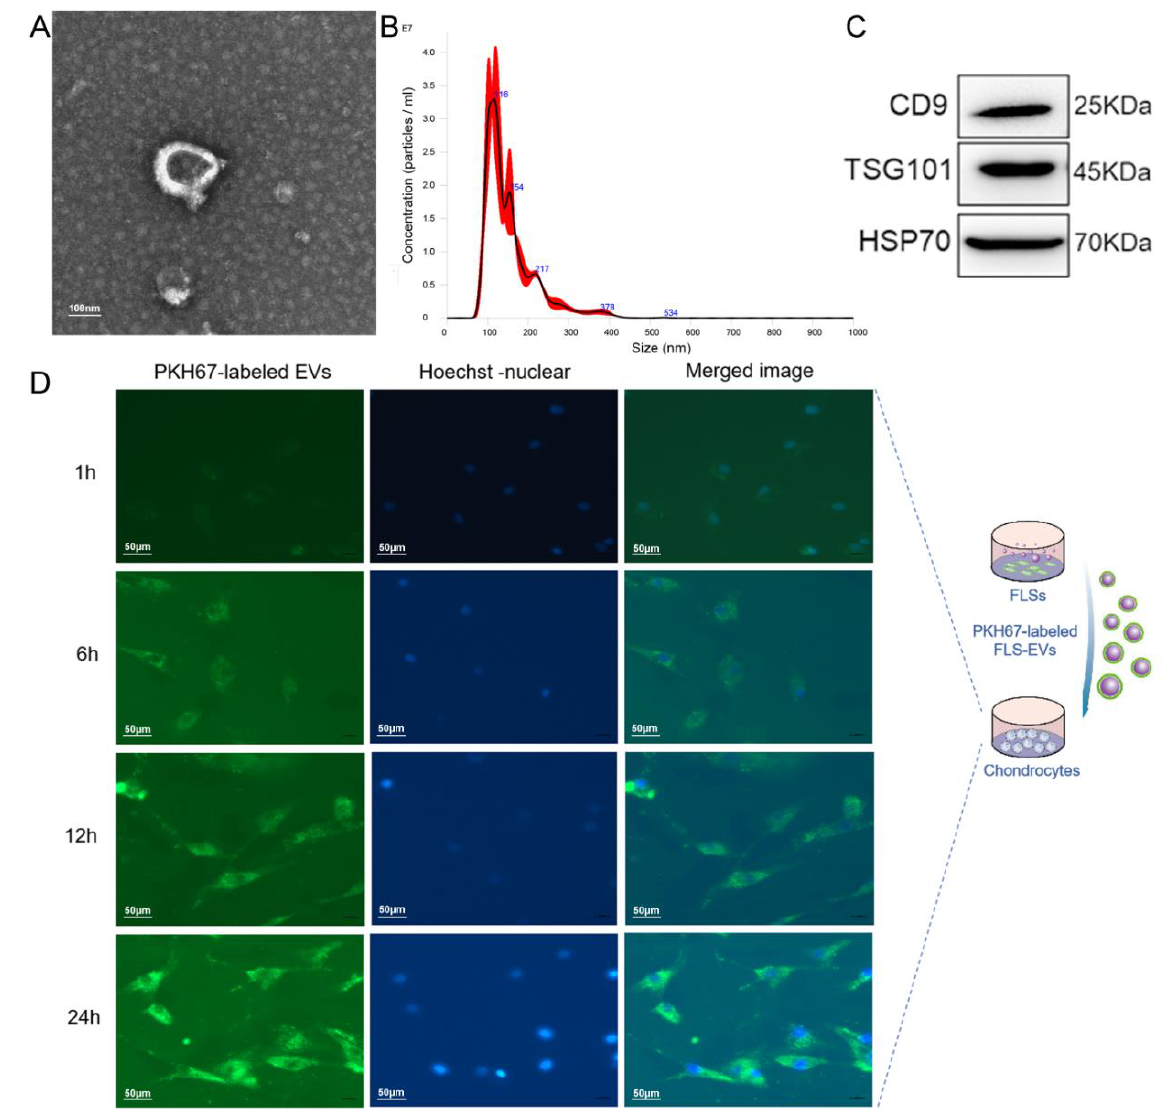
Figure 7. The identification FLS – EVs and uptake of FLS – EVs by chondrocytes. ( A ) TEM observation of the EV morphology. ( B ) NTA measuring of the EV particle distribution and concentration. ( C ) WB analysis of the EV markers CD9, TSG101, and HSP70. ( D ) Representative immunofluorescence images of chondrocytes at various time points, showing the uptake of PKH67 (green)-labeled EVs. Hoechst (blue) staining was performed to label the nuclei.